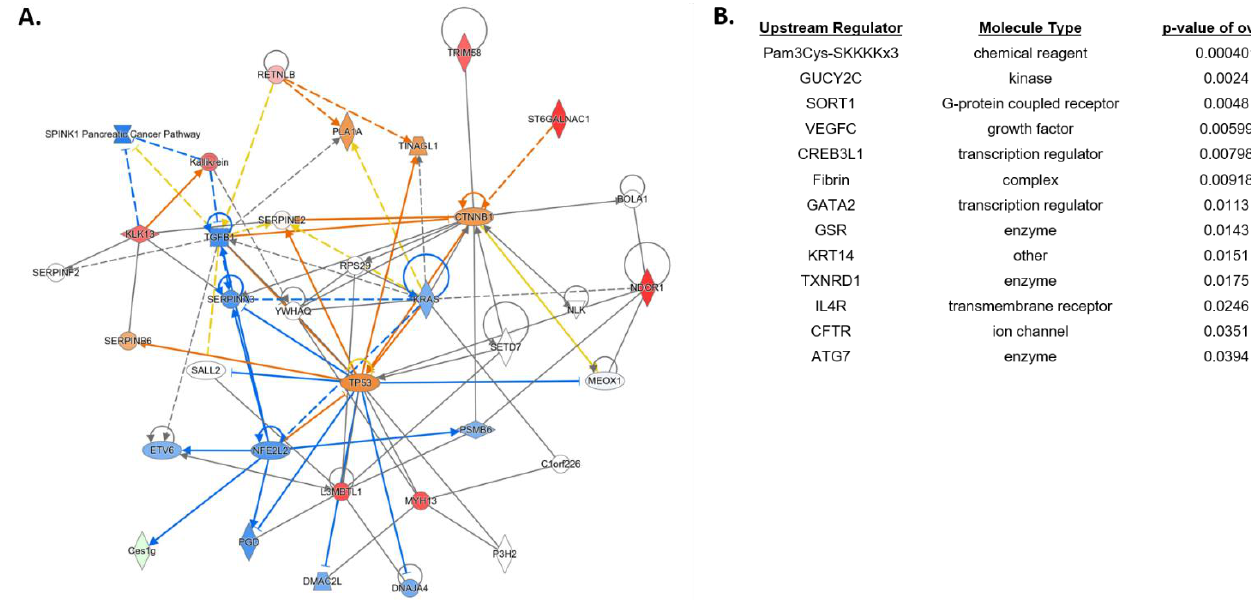
Figure 5. Differential gene expression of terminal ileum of NEC + HA pups compared with un- treated NEC pups. ( A ) Predicted network involving differentially regulated pathways and genes. ( B ) Top predicted upstream regulators associated with HA pretreatment of NEC pups. Blue = Z-score < − 2 (predicted downregulation), orange = Z-score >2 (predicted upregulation), red = actual upregulated gene, green = actual downregulated gene. NEC: necrotizing enterocolitis; HA = hyaluronic acid.